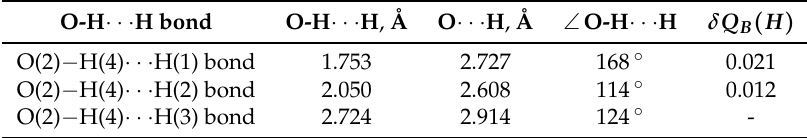
Table 5. Canonical proof of dihydrogen bonding in Y 2 H 3 O(OH) in terms of hydroxid–hydride bond connectivities. The last column shows the bond–charge correlation: the difference δ Q B ( H ) means the characteristic loss of charge of the hydride anion (in units of | e | ) participating in the dihydrogen bonding with respect to the effective charge on noninteracting